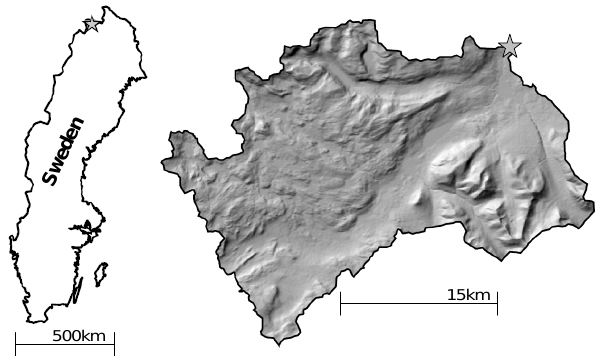
Fig. 1. Site map showing the Abiskojokken catchment in north- ern Sweden with the outlet (indicated by a star) at 68 ◦ 21 0 36 00 N, 18 ◦ 46 0 48 00